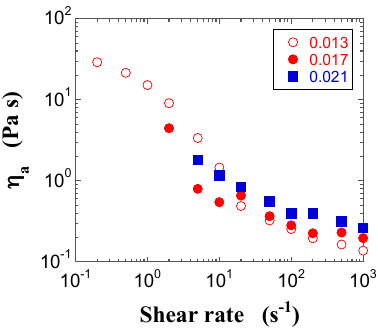
Figure 5. Double-logarithmic plots of the apparent steady-state shear viscosities ( η a ) for the FS suspensions at φ = 0.013 (open red circle), 0.017 (filled red circle), and 0.021 (filled blue square) as a function of the shear rate.